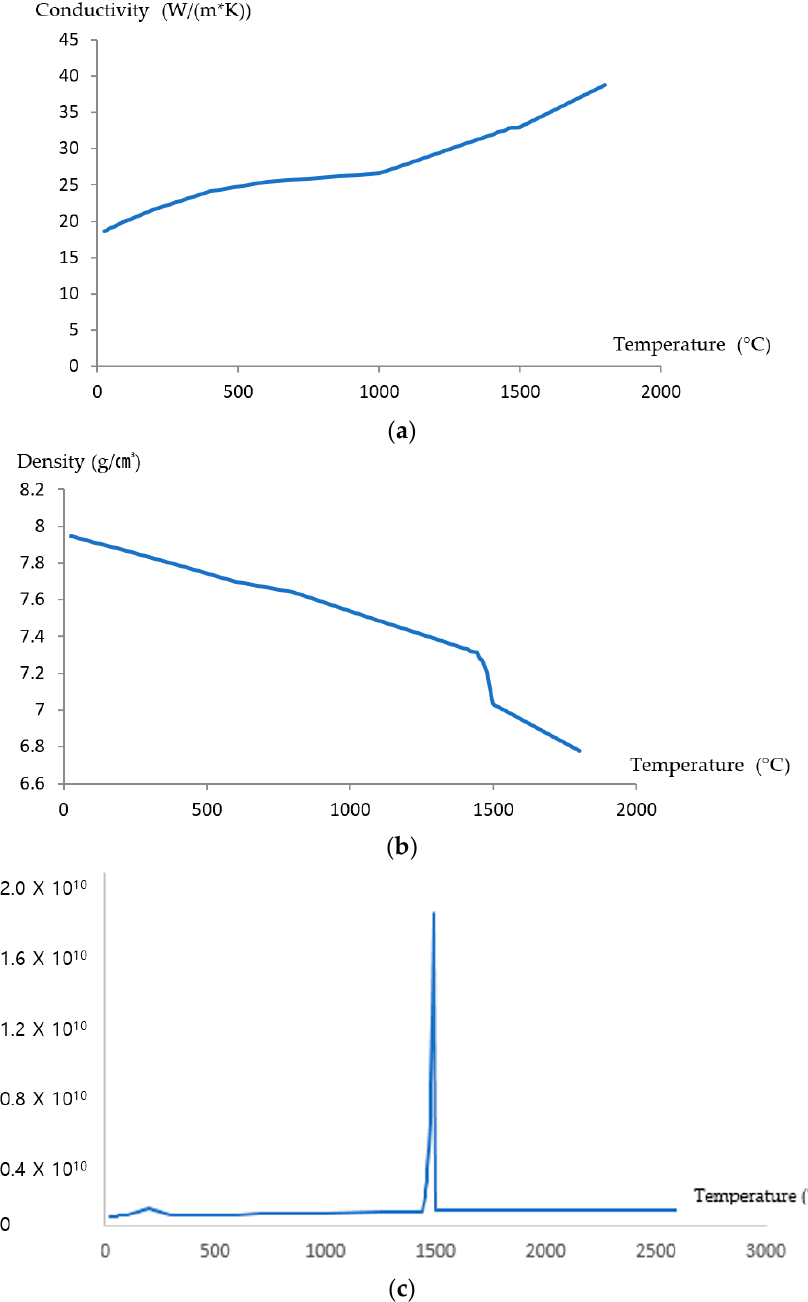
Figure 6. Material properties of 9% nickel steel by temperature. ( a ) Conductivity. ( b ) Density. ( c ) Specific heat.